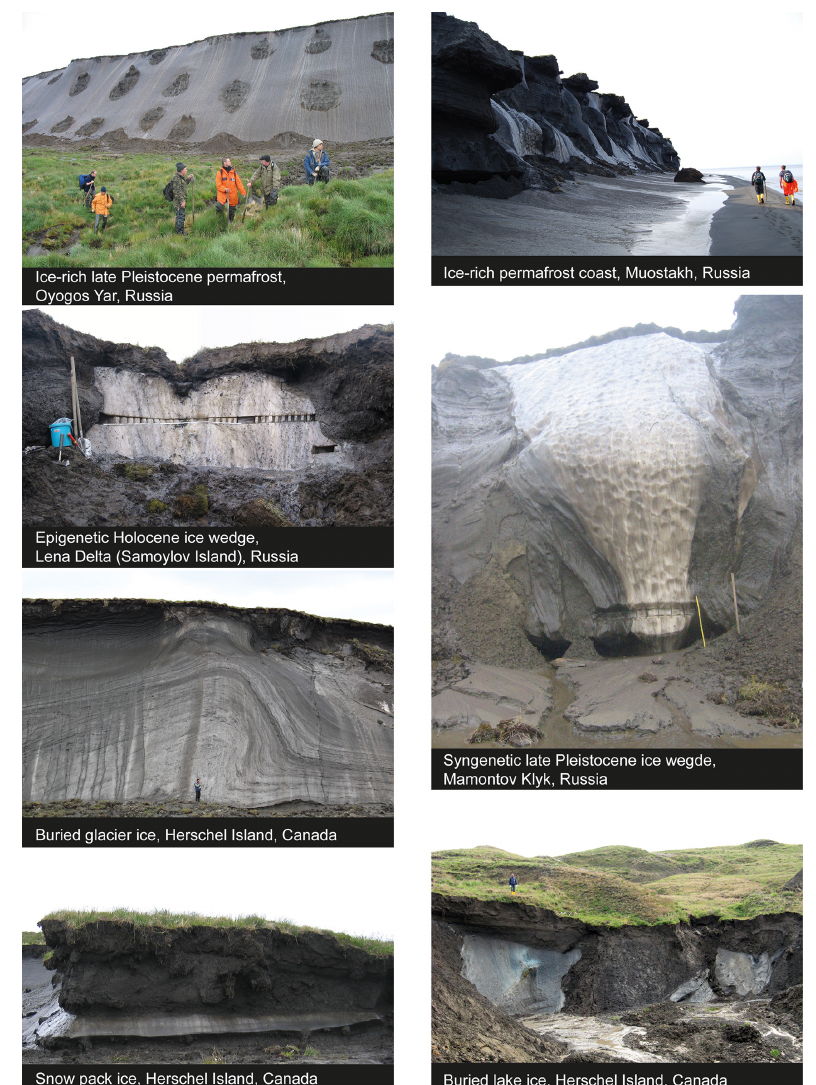
Figure 2. Ground-ice conditions and examples of studied ground-ice types in the Siberian and North American Arctic. Place names are plotted on Fig.